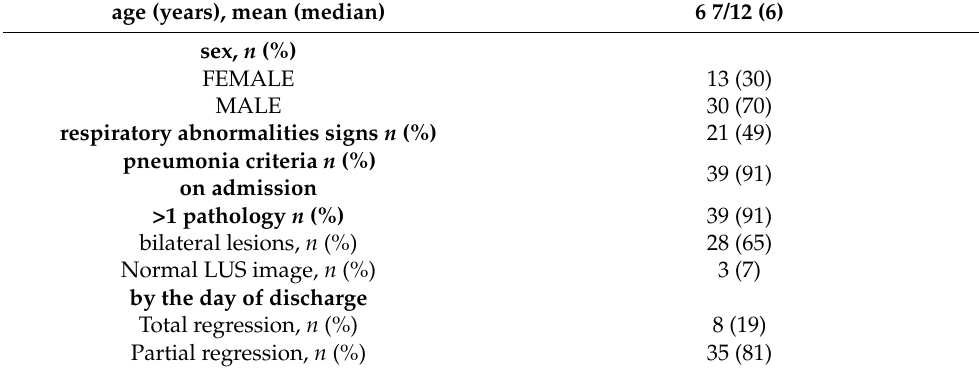
Table 1. Study group.